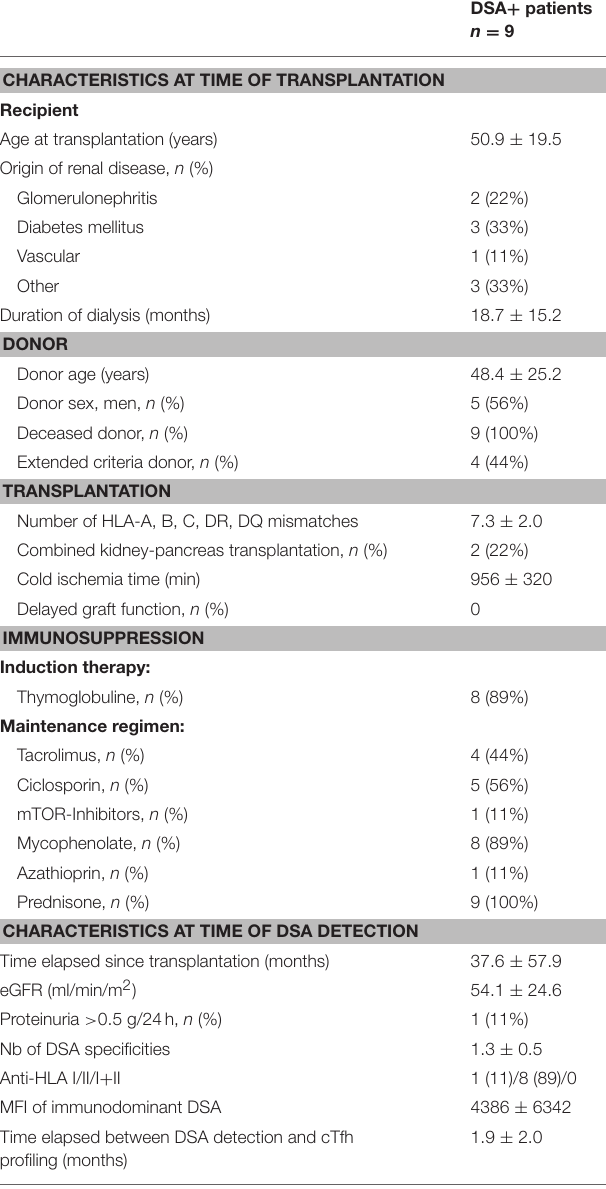
TABLE 3 | Characteristics of DSA +